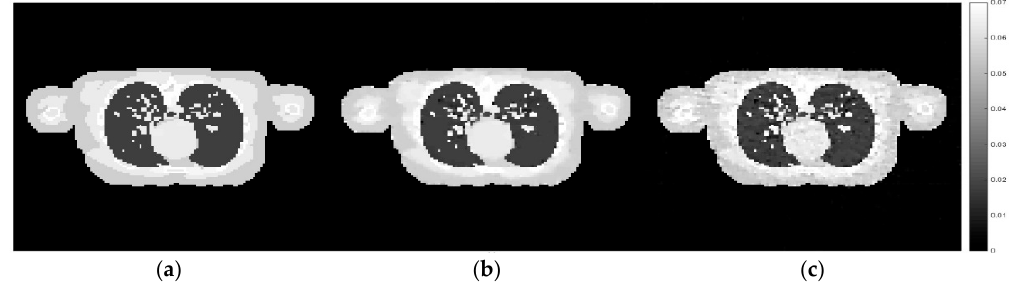
Figure 14. Cross-sectional slices of ( a ) the exact image, ( b ) the reconstruction from the proposed method directly imple- mented on the female phantom data, ( c ) the reconstruction using the set of hyperparameters from the training dataset. The display window is